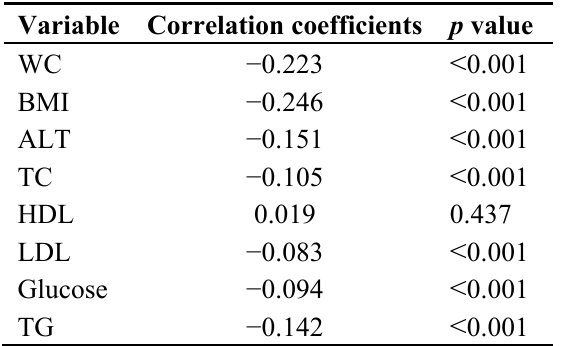
Table 2. Age-adjusted Spearman correlations between osteocalcin and